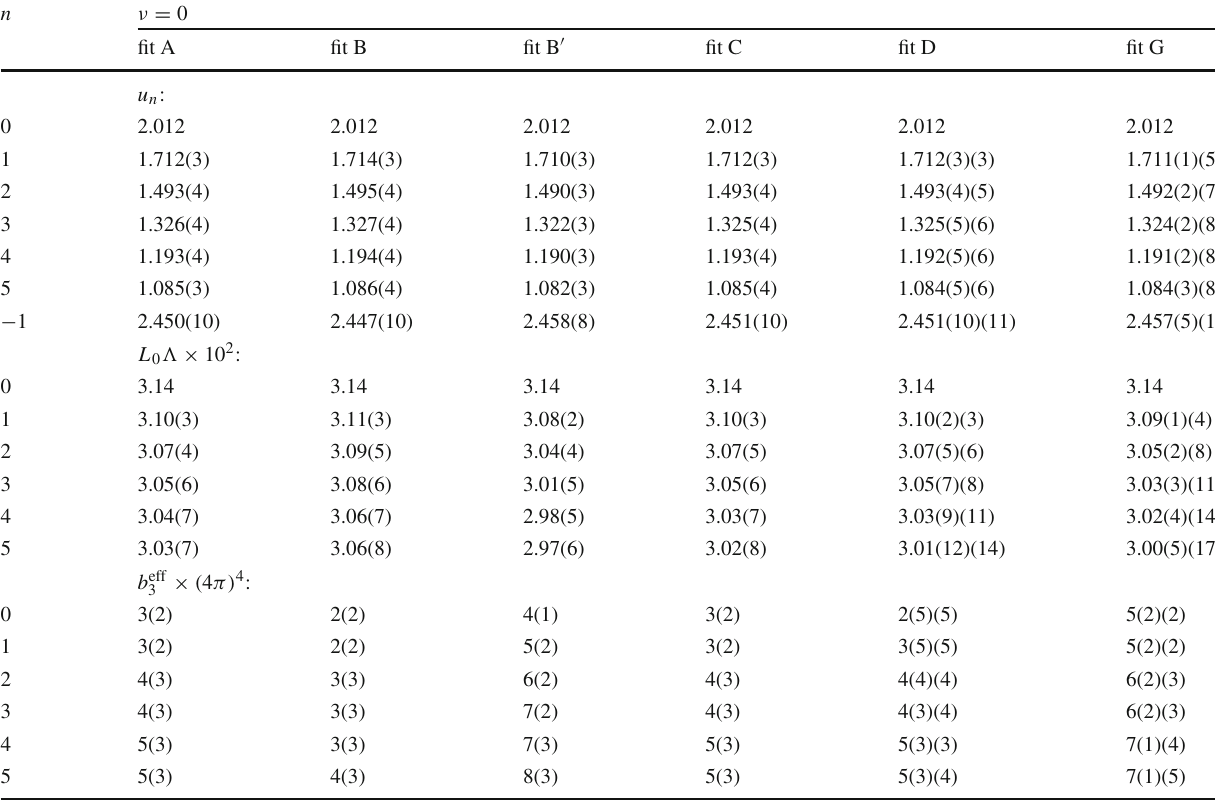
Table 6 Results for the couplings u n = ¯ g 2 ν ( L n ) , the (cid:2) -parameter evaluated at u n , cf. Eq. (4.15), in units of the reference scale, L 0 (4.9), and the effective β -function coefficient, b eff (4.14), for most fits of Table 5. Results for L 0 (cid:2) obtained with fits E, F and H are given in Table 3